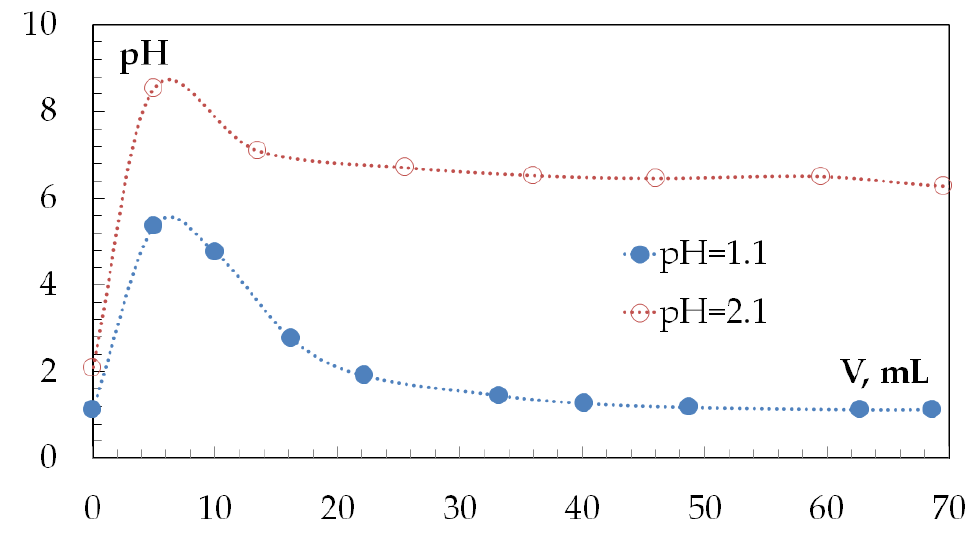
Figure 7. Dependence of the washing solution pH values after sorption. Sorption studies of mercury, iron and lead ions were carried out on pre-washed organic material. The phases ratio, pH values, initial and equilibrium concentrations of the solution are presented in Tables 5 and